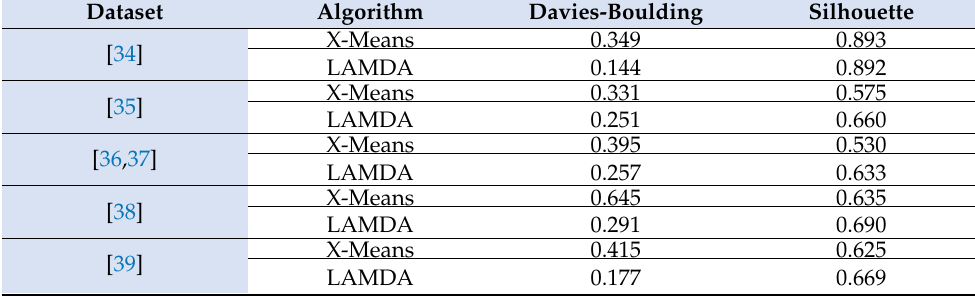
Table 3. Results of the clustering models in different